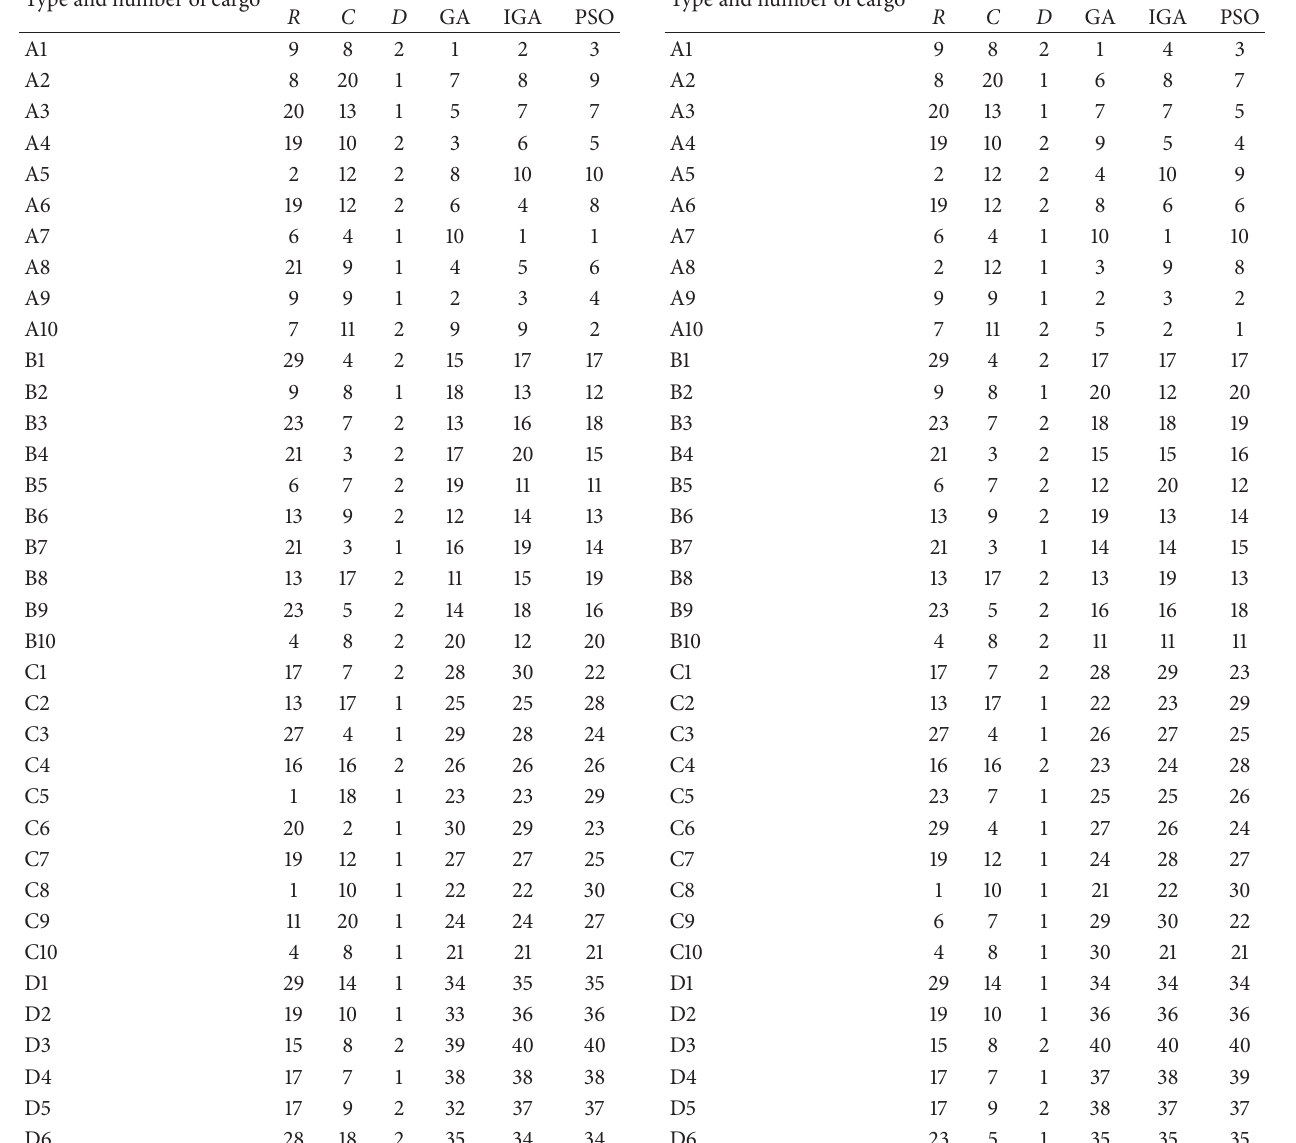
Table 3: The addresses of the stored cargo for simulation in Case 3. Type and number of cargo